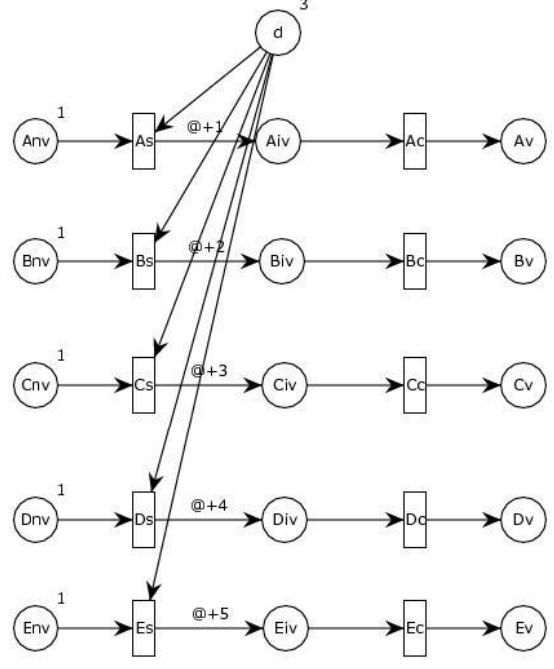
Figure 9. Five cities connected through depo. Figure 10. Five cities connected through